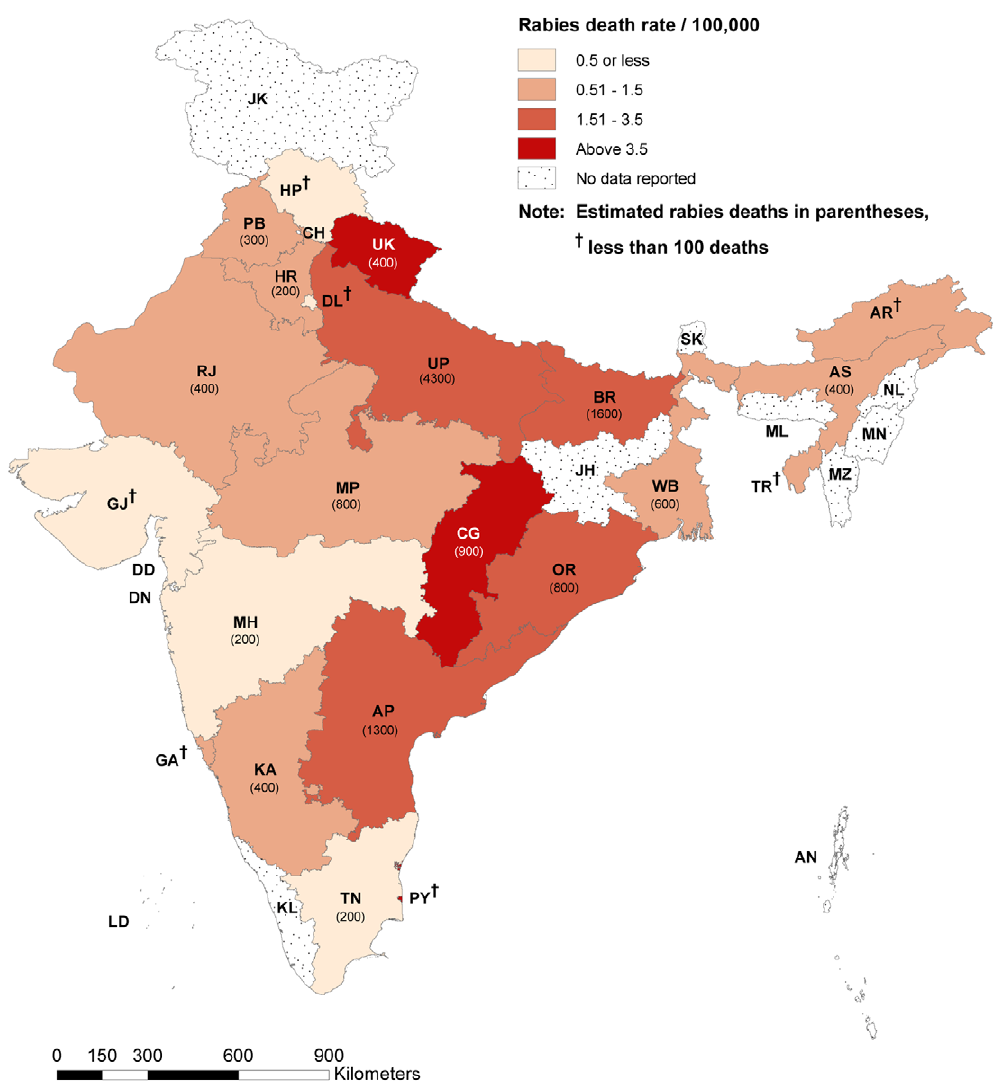
Figure 1. Regional variation of estimated rabies deaths and death rates: India, 2005. State wise death rates are standardized to 2005 UN population estimates [27] for India. Total estimated rabies deaths for India in the present study is 12,700, 99% CI (10,000, 15,500). Areas where no rabies deaths captured by this study represent 7% of the total India population. Figure S1 shows a comparison of state level rabies deaths reporting from present study and other mortality studies available. Abbreviations: Larger states U: AP-Andhra Pradesh, AS-Assam, BR-Bihar,